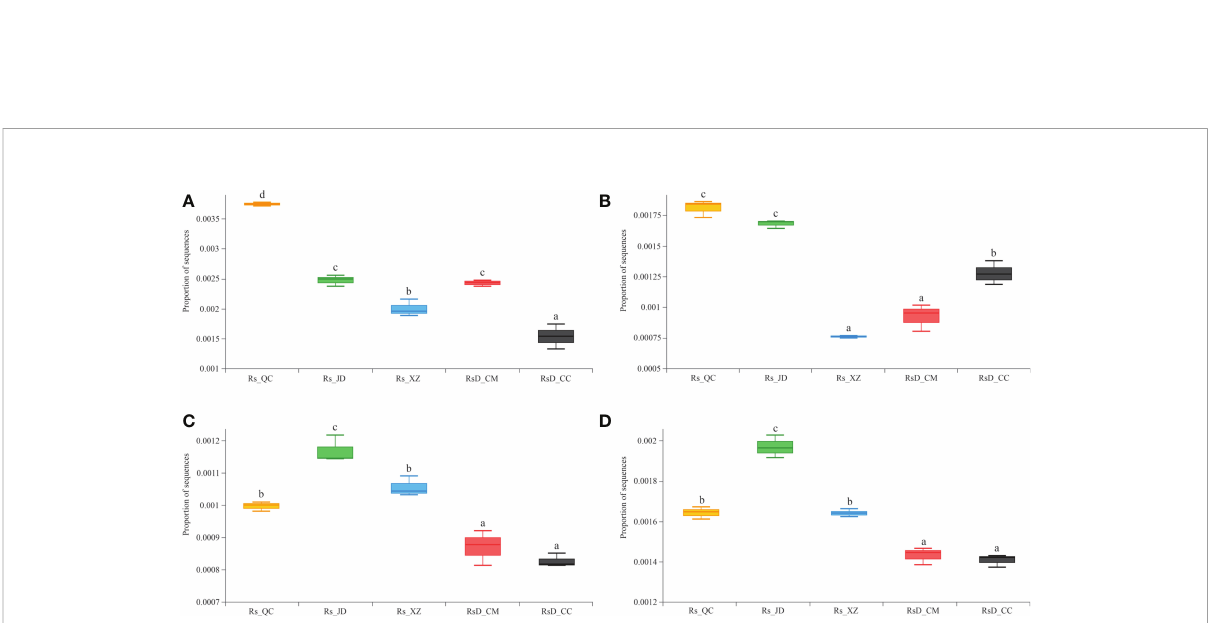
FIGURE 4 Boxplot of functional gene sequences proportion. (A) chitinase; (B) b -1,3-glucanase; (C) spermidine/putrescine transport system substrate- binding protein; and (D) aldehyde dehydrogenase (group signi fi cance is indicated by letters; non-identical letters indicate p < 0.05).